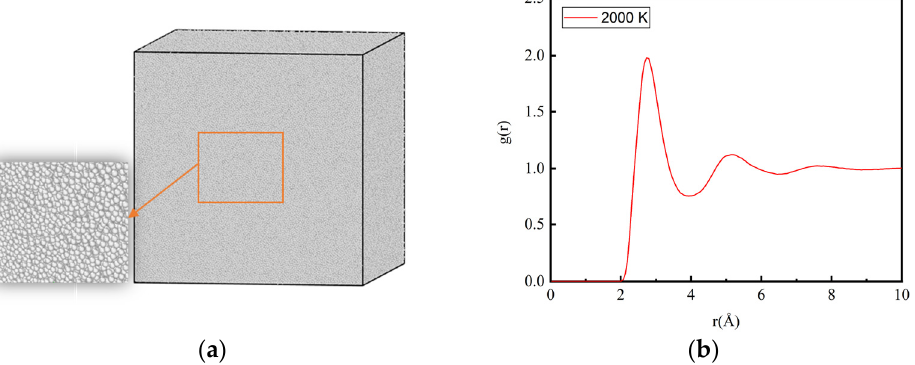
Figure 1. Al melt model at 2000 K and its RDF curve. ( a ) MD model. The left inset is the magnified view of the center part of Al melt. ( b ) RDF curve.